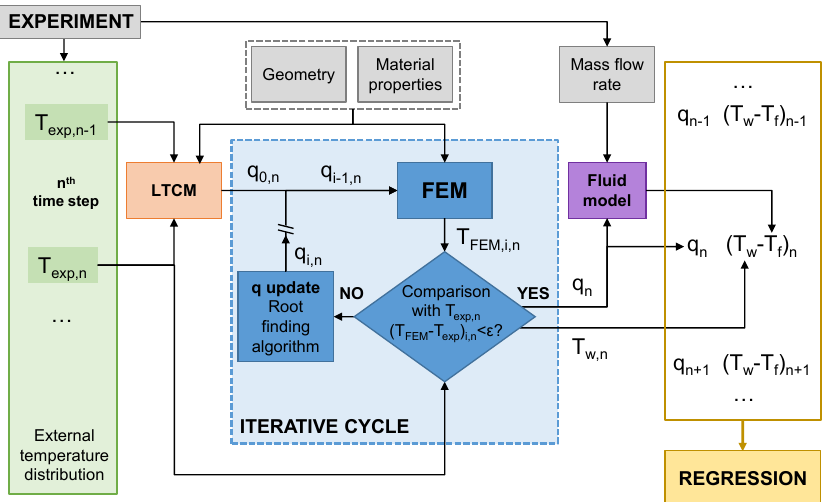
Figure 2. Schematic of the proposed